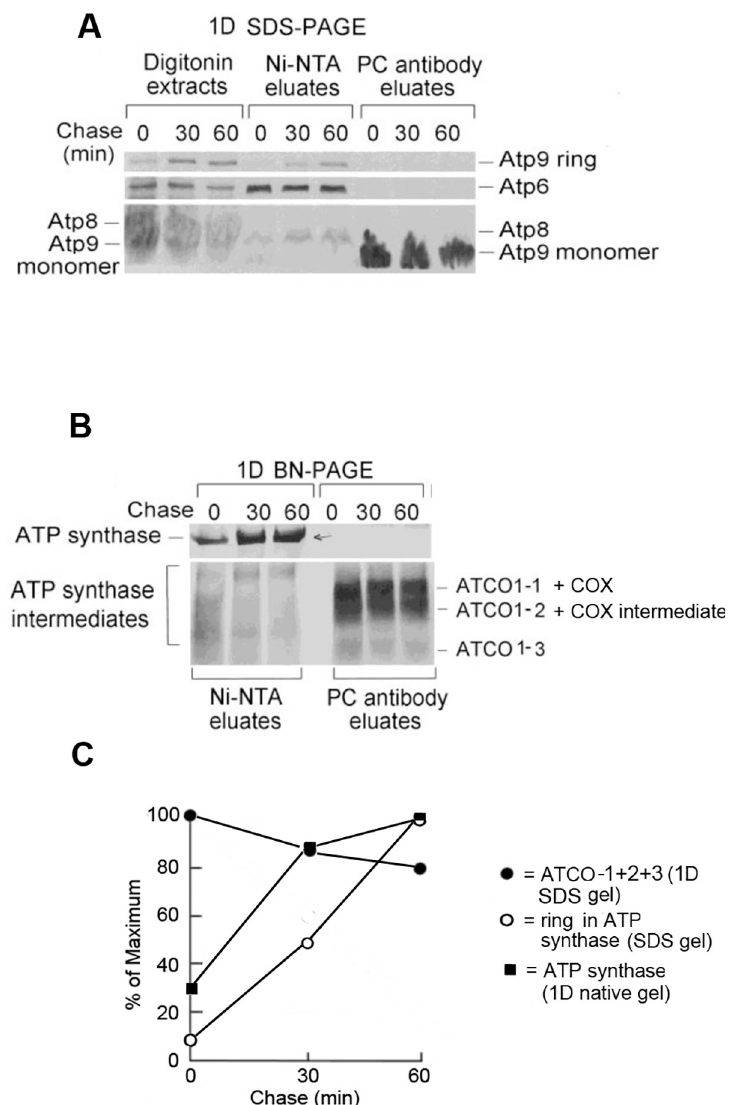
Fig 2. Pulse-chase analysis of Atco complexes. A . Mitochondria from W303/COX6-HAC,ATP6-HApH, a strain expressing Atp6 tagged with poly histidine and Cox6 with protein C epitope was pulse-labeled with 35 S-methionine/ cysteine for 10 minutes and chased for 0, 30 and 60 minutes. The mitochondria were extracted with 2% digitonin and purified on Ni-NTA beads to pull down partially and fully assembled ATP synthase. The same volume aliquots of the digitonin extracts were purified on protein C antibody (PC) beads to pull down Atco complexes. The affinity purified proteins were separated by SDS-PAGE on a 12% polyacrylamide gel and by BN-PAGE on a 4–13% polyacrylamide gel. B . The proteins purified on Ni-NTA and on the protein C antibody beads were separated by BN-PAGE. C . The radiolabeled Atco complexes (1D BN gel of PC eluates), ATP synthase intermediates and Atp9 ring (1D SDS gel of PC eluate) were quantified with a phosphorimager. The Atco complexes overlap with cytochrome oxidase and Cox1 intermediates, which contribute approximately 10% of the radiolabel in that region of the 1D blue-native